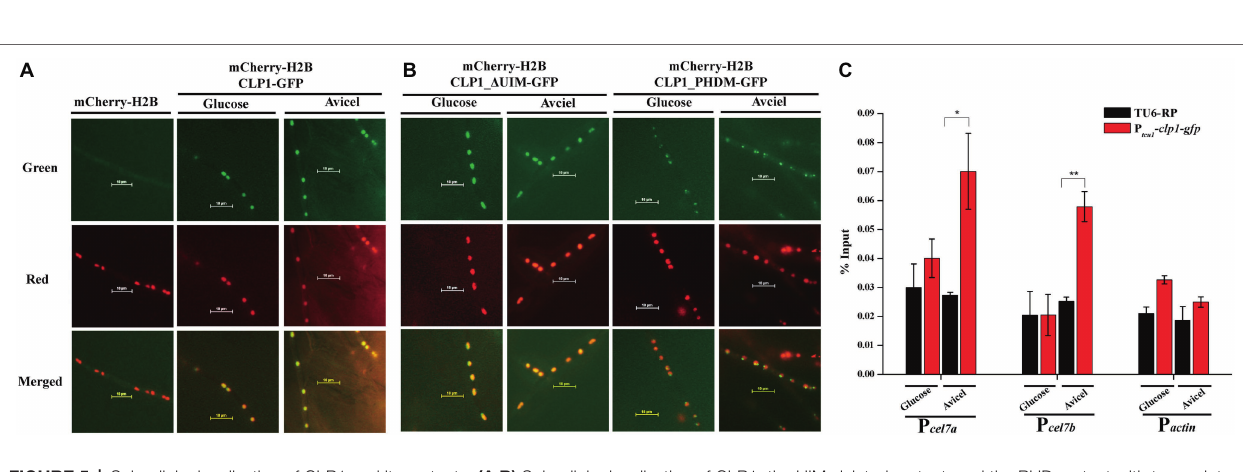
FIGURE 5 | Subcellular localization of CLP1 and its mutants. (A,B) Subcellular localization of CLP1, the UIM-deleted mutant, and the PHD mutant with two point mutations (C145A and H150A) tagged with GFP at the C-terminus, respectively. Germinated hypha of T. reesei transformants of mCherry - h2b , mCherry - h2b & clp1 - gfp , mCherry - h2b & clp1_ ΔUIM- gfp , and mCherry - h2b & clp1_ PHDM- gfp cultured on 1% (w/v) glucose or Avicel was subject to fluorescence analyses, respectively. (C) CLP1 is recruited to the cellulase gene promoters upon cellulose induction. ChIP analyses of CLP1 occupancy on the cellulase gene promoters of cel7a , cel7b , and the control gene actin in the P tcu1 - clp1 - gfp and TU6-RP strains cultured on 1% (w/v) Avicel or glucose for 24 h. Significant differences ( t test, ** p < 0.01, * p < 0.05) were observed in the occupancy of CLP1 on the cel7a and cel7b promoters between the control TU6-RP and the P tcu1 - clp1 - gfp strain under Avicel- inducing conditions. Values represent the mean of three biological replicates. Error bars are the SD from these